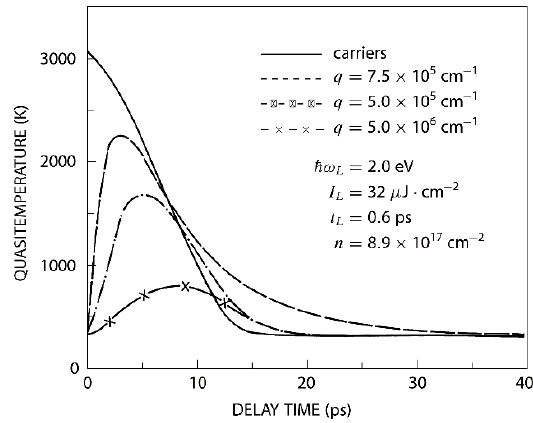
Figure 7. Evolution of the quasitemperature of the carriers and three LO-phonon modes, for the conditions indicated in the upper right